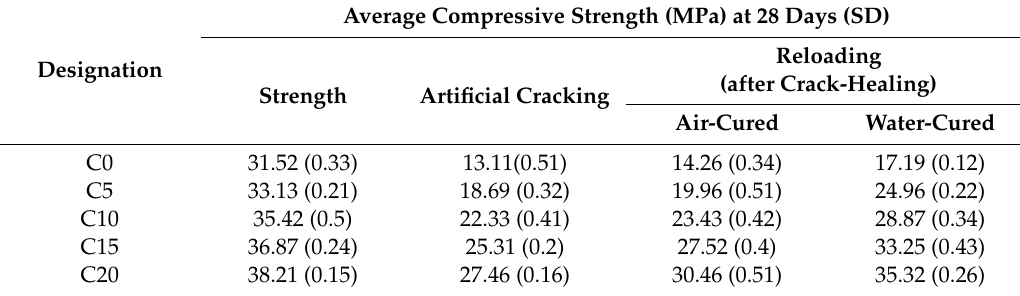
Table 4. Compressive strength regained due to the crack healing e ff ect of